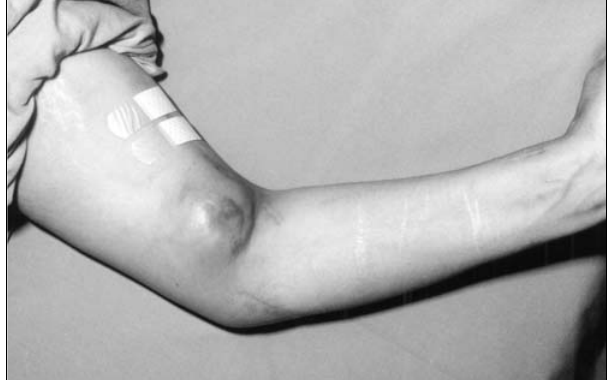
Figure 1) The arteriovenous fistula aneurysm in the antecubital fossa of the patient’s left arm